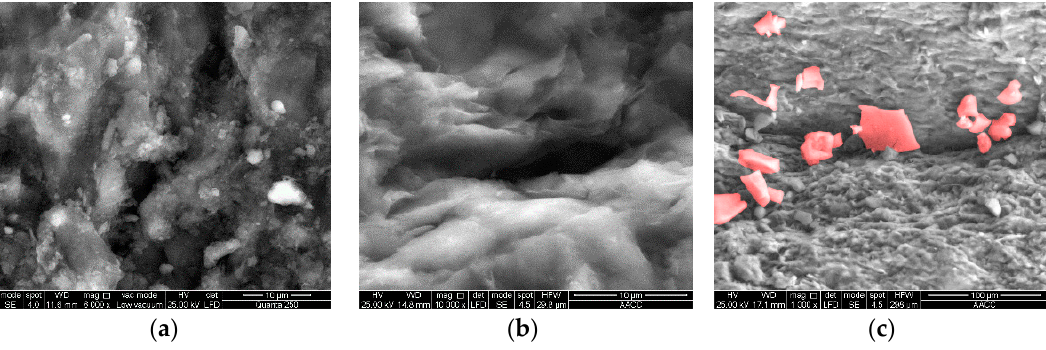
Figure 9. Micropore, microfracture, and gel filling form of sample. ( a ) Original rock sample; ( b ) surface of saturated rock sample after drying; ( c ) fresh cut of saturated rock sample after drying, rendering pseudo-color with Adobe Photoshop CS6. The red pseudo-color regions are silica gels.